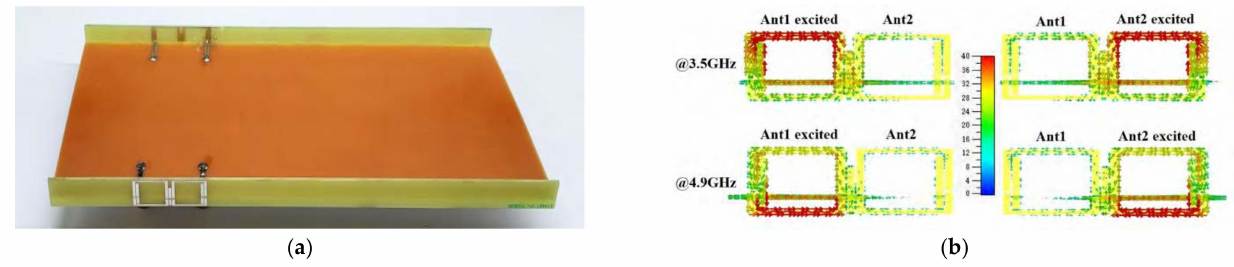
Figure 4. MIMO antenna with grounding branches: ( a ) geometry of proposed MIMO; and ( b ) the current distributions with DGS (Results from [48]).